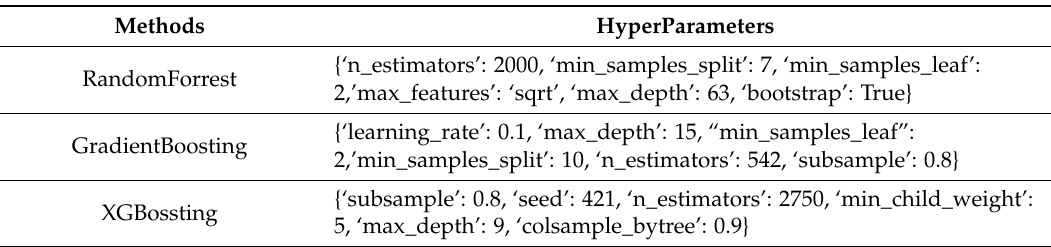
Table 3. HyperParameters used in each